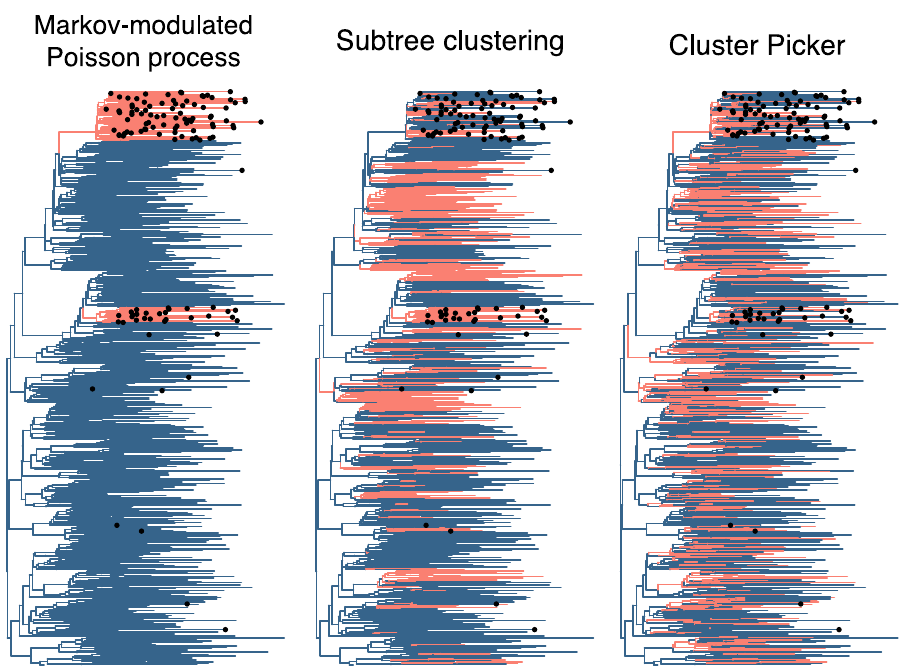
Fig 3. Comparison of predicted clusters and actual clusters of fastertransmission. We mappedthe clusteringpredictionsfrom three different methods (Cluster Picker, subtree clusteringand MMPP) onto one of the neighbor-joiningtrees reconstructed from sequencedata simulatedunder the faster-transmission scenario.Branchesare coloured light red if the method assigns that branchto a cluster, and dark blue otherwise.The correct assignments are indicatedby labelingtips with filled circles if they belongin a cluster. Cluster Picker (version 1.2.4) was run with default initial and main support thresholds (0.9) and a genetic distancethreshold of 0.025. Subtree clusters were extracted from the tree with a bootstrapthresholdof 90% and mean branch length threshold of 0.0065.